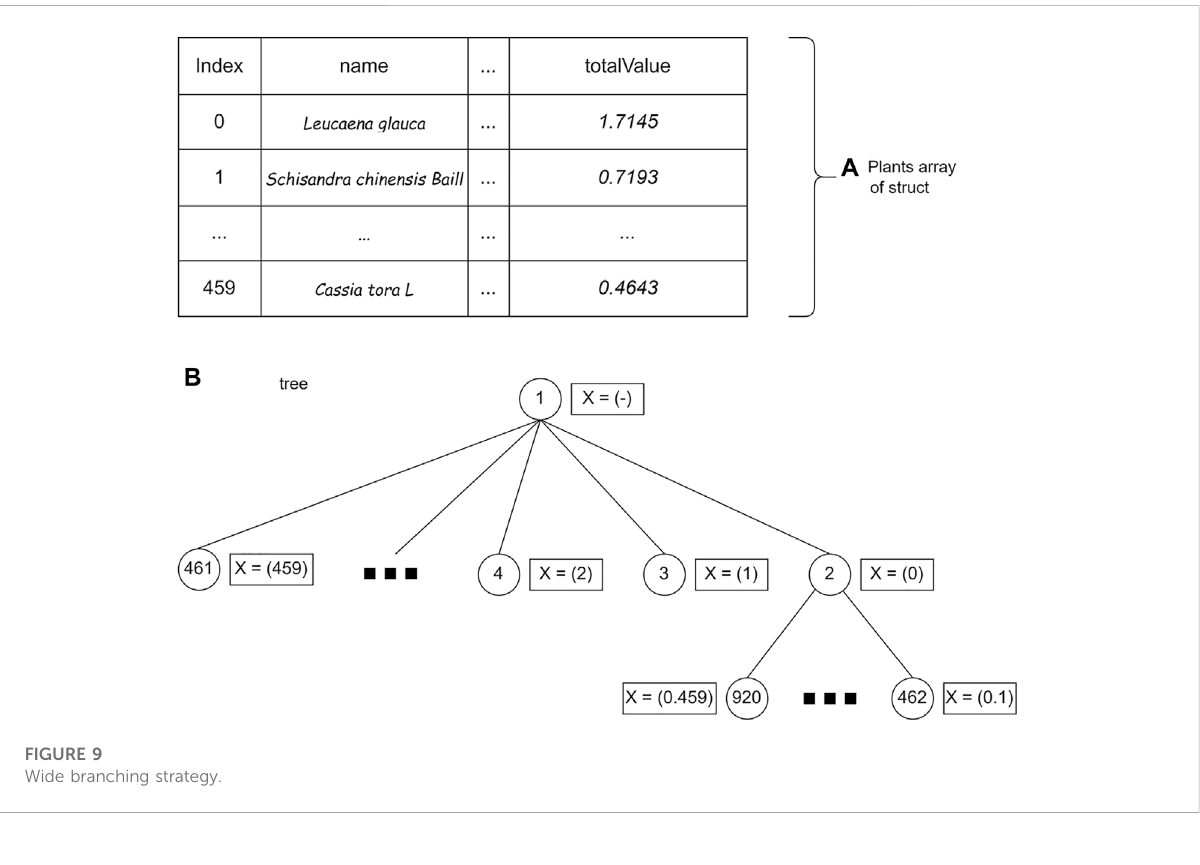
TABLE 3 Complete data on the computational time for each strategy. The number of